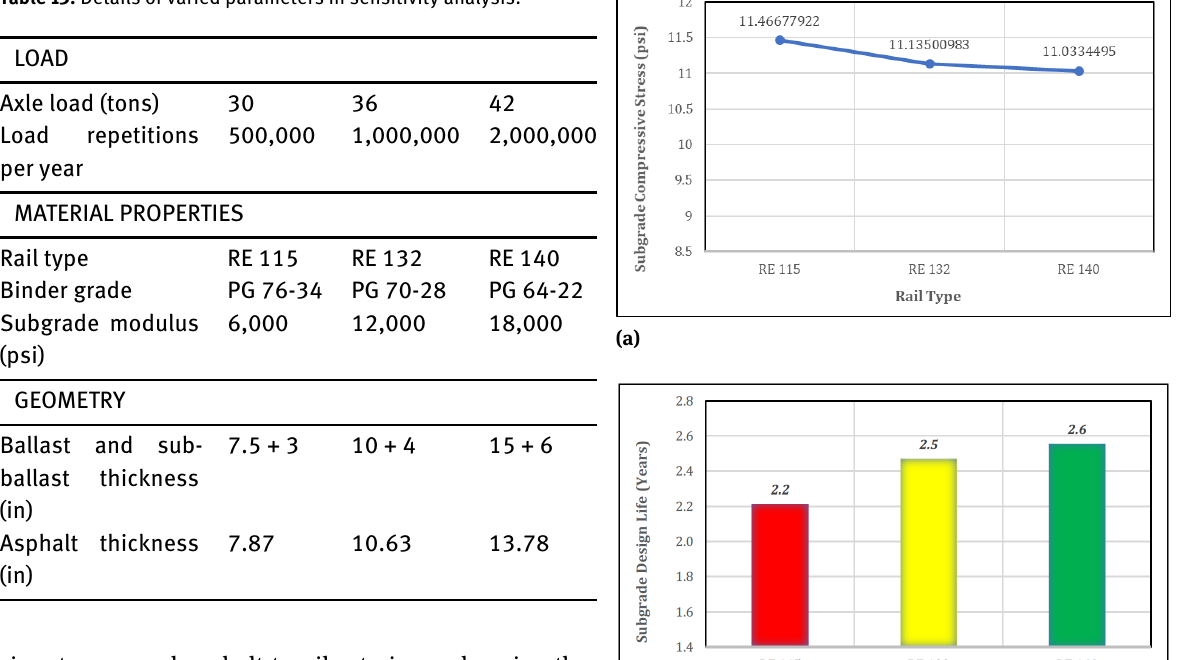
Table 13: Details of varied parameters in sensitivity analysis.